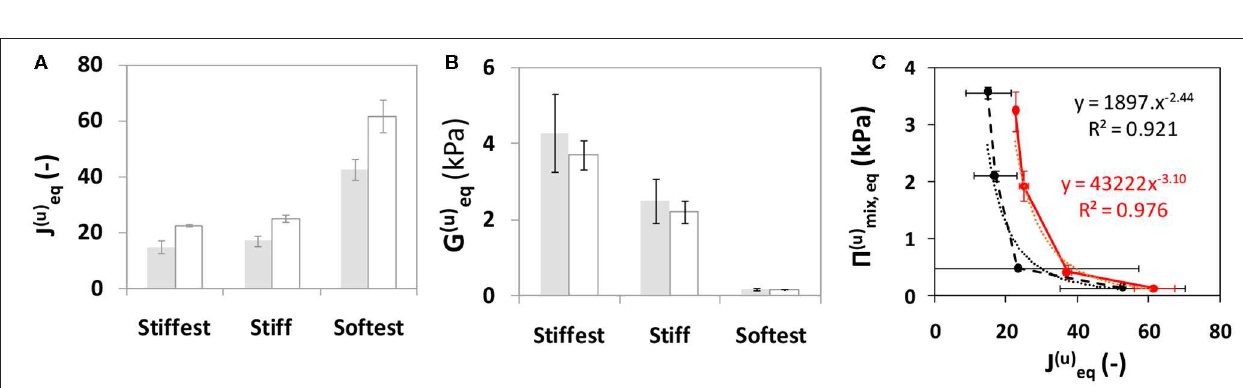
FIGURE 5 | Gel swelling and elastic properties at equilibrium swelling (Day 1) conditions predicted (gray bar) and measured (white bar) under unconstrained swelling conditions. Dependence of (A) swelling ratio and (B) shear modulus on gels with varying cross-linker concentration (see Table 1 ) but identical monomer concentration (8% w/v); and (C) dependence of predicted osmotic pressure due to mixing on predicted/measured swelling ratio for all four gel compositions. Whiskers indicate